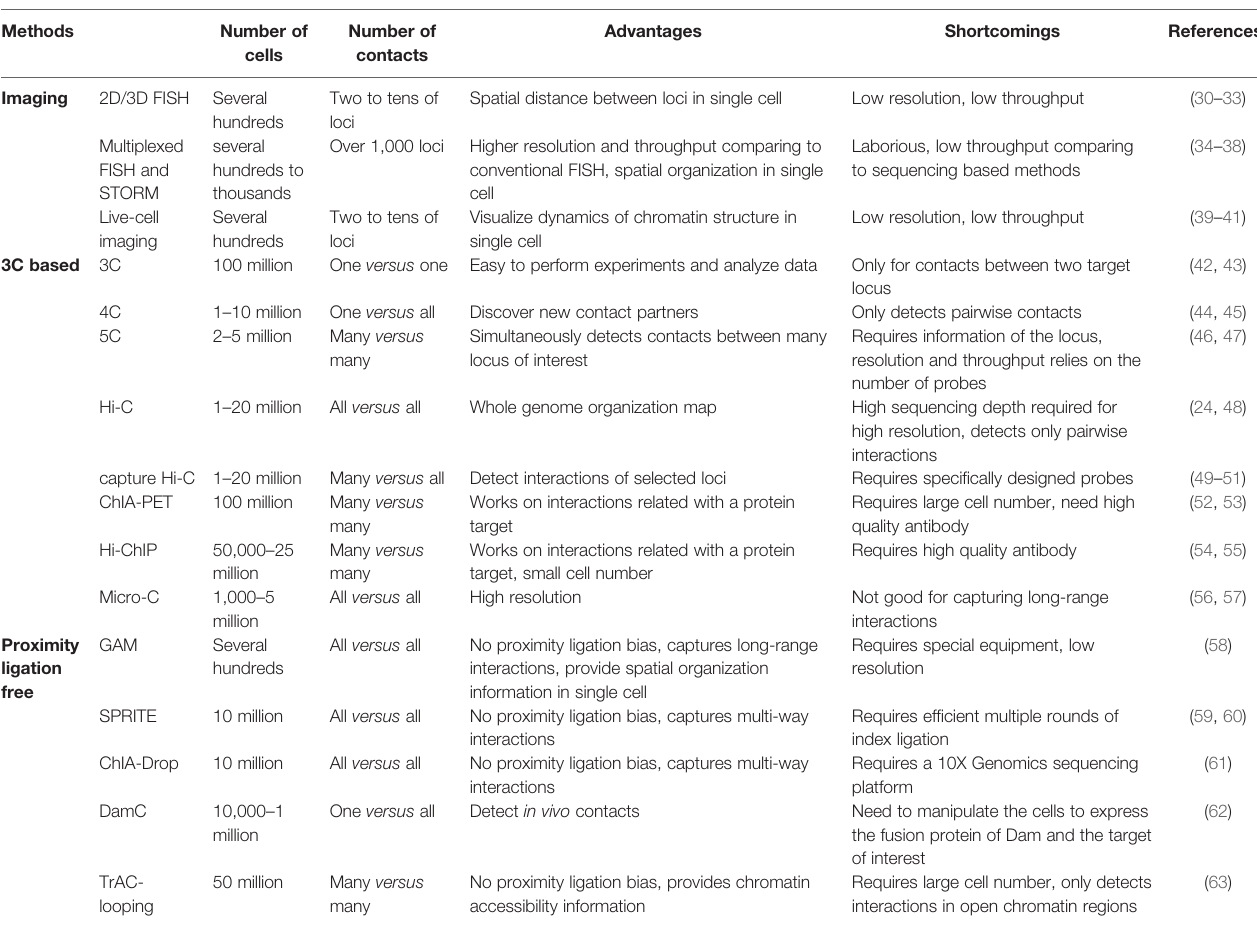
TABLE 1 | Comparison of the features of techniques for elucidating chromatin structures.